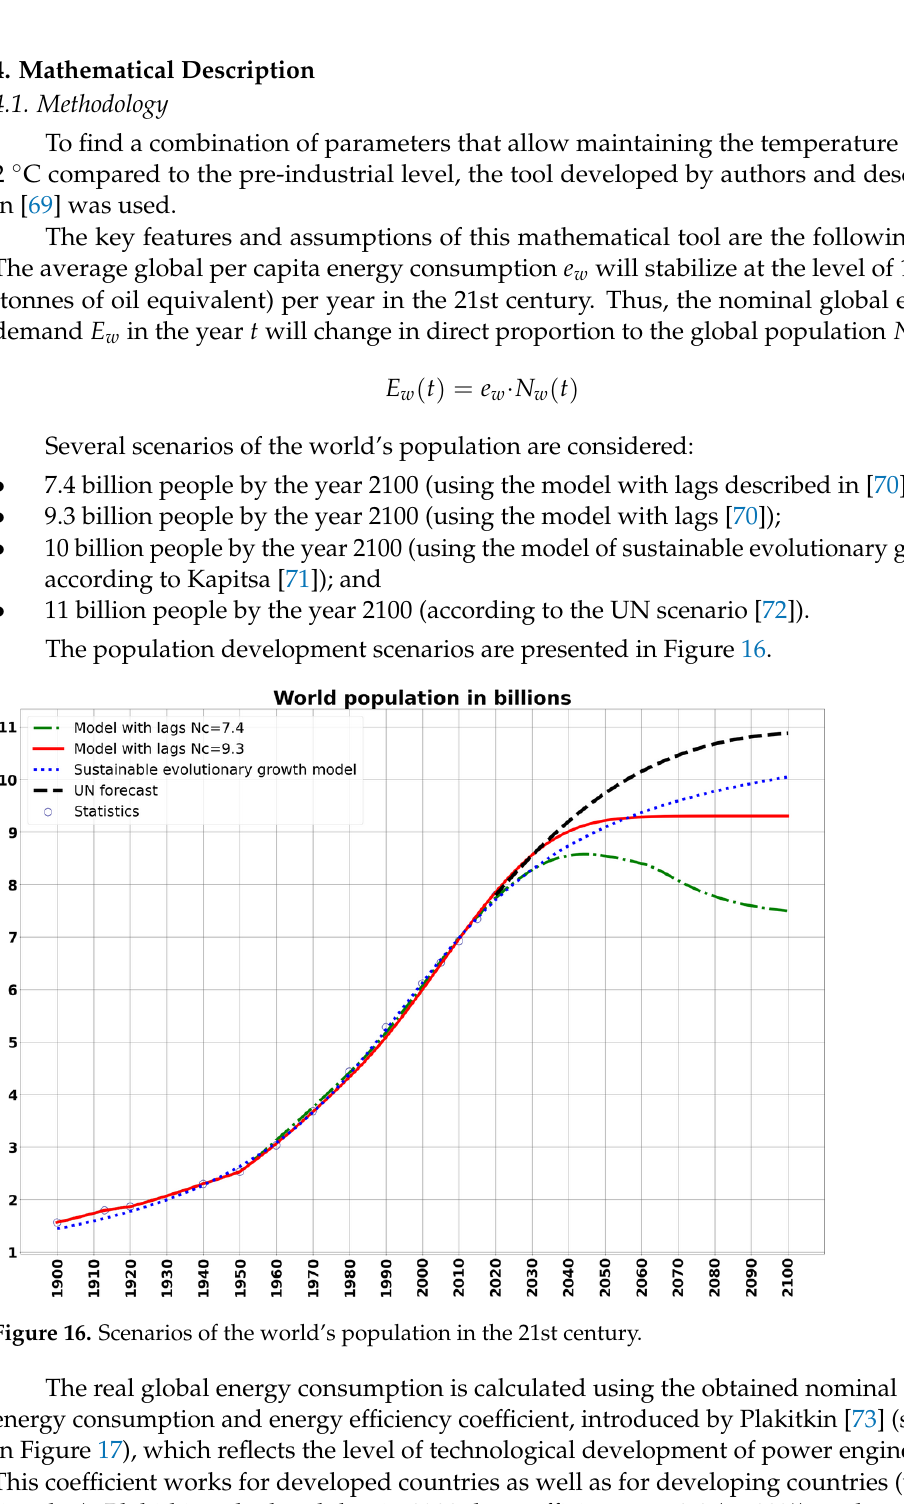
Figure 17. Energy use coefficient (percentage). The dynamics of real global energy consumption in the 21st century are presented in Figure 18.